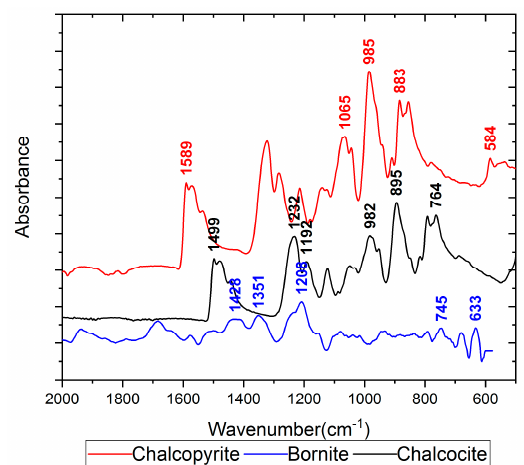
Figure 20. The DRIFT spectra of the dithiophosphate and xanthate collector blend (1:1) adsorption on copper sulphides at pH 8 and a total concentration of collector 3 × 10 − 5 M.